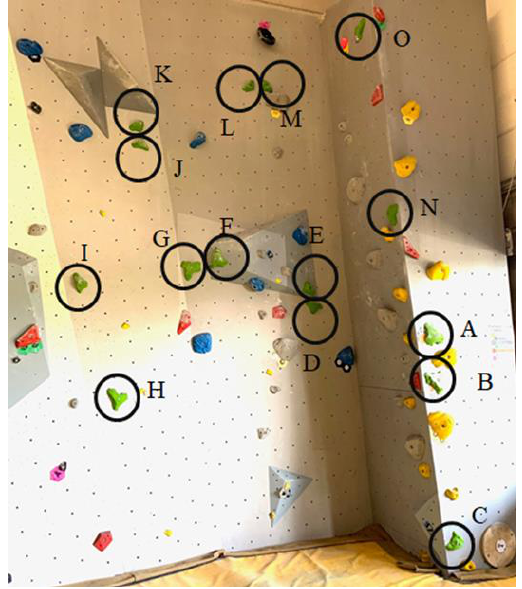
Figure 3. The second route in the domain-specific cognitive test (climbing test) with marked grips and holds (letters A–O).